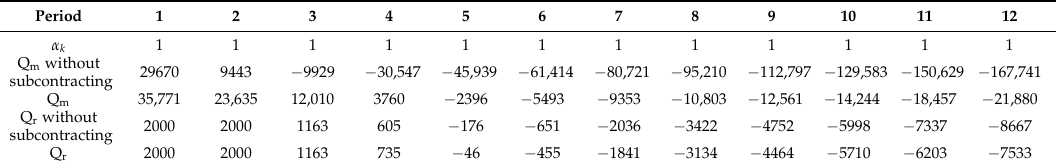
Table 8. Amount of emitted carbon during the different process with Q cm = 50,000 and Q cr = 2000. Period